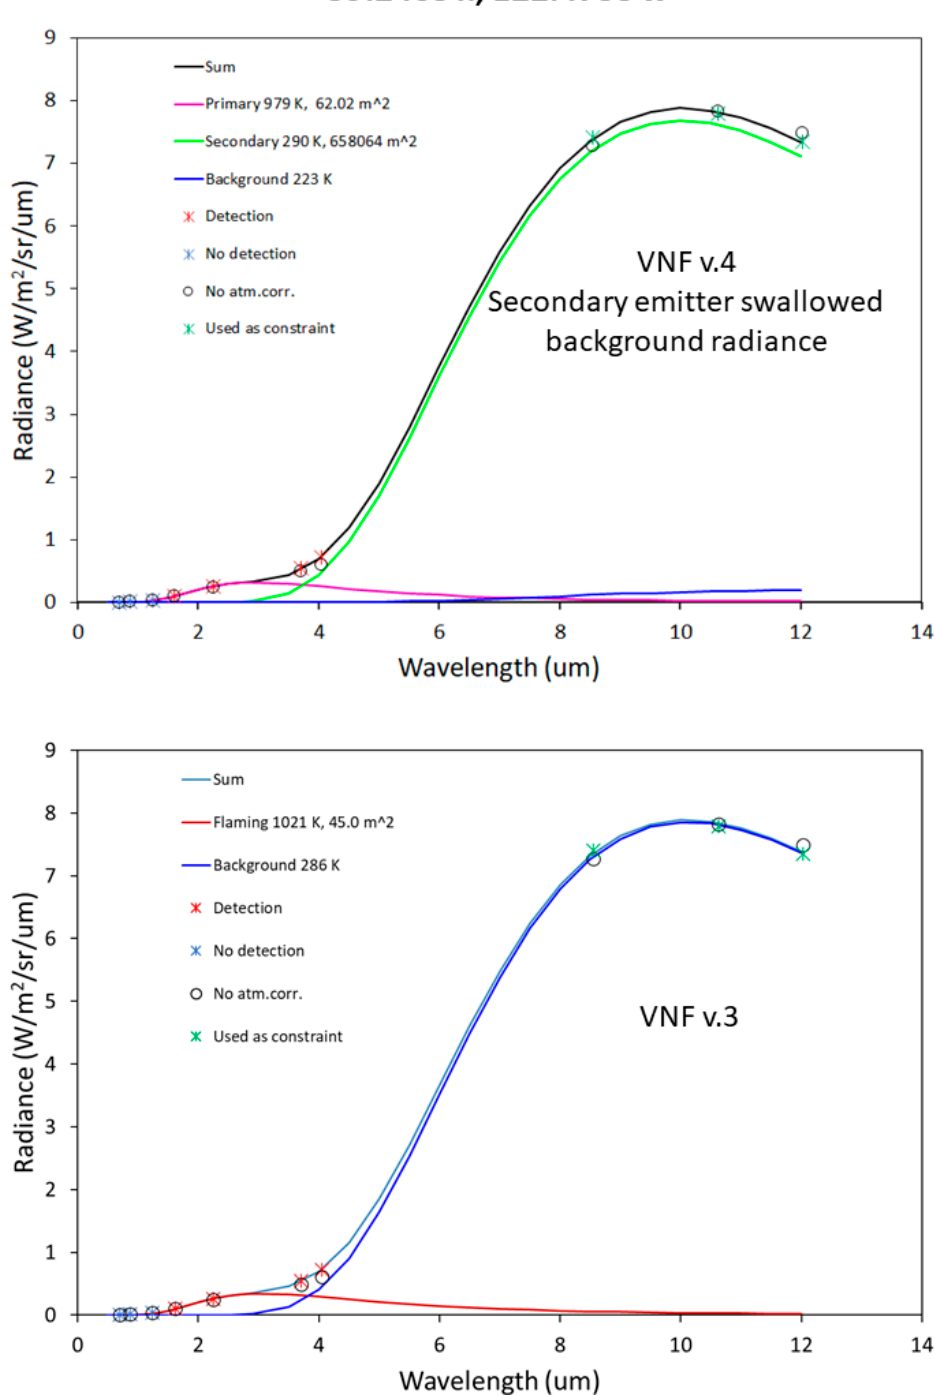
Figure 13. Spectral diagrams of a Type 4 misfit pixel from the Mendocino Fire where the 2nd phase has absorbed a large portion of background radiance. The pixel moves from Type 4 to Type 5 with the VNF v.3 fit.